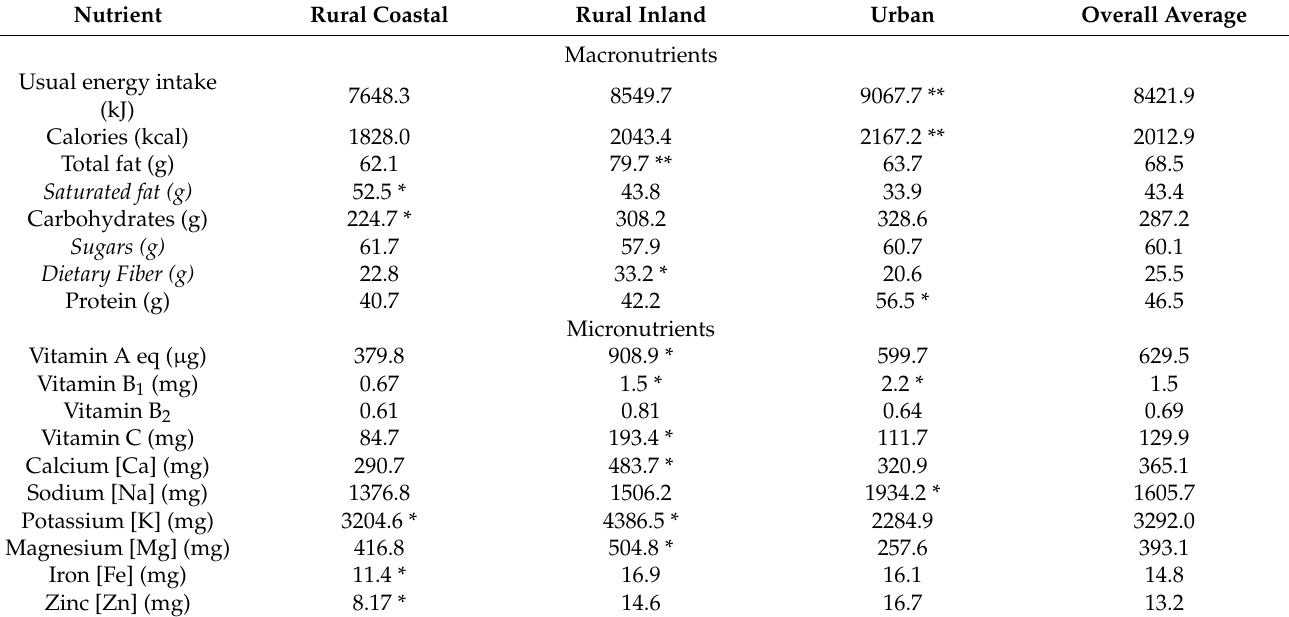
Table 3. ANOVA comparisons of usual macro- and micronutrient intakes among three unique populations ( n = 94).